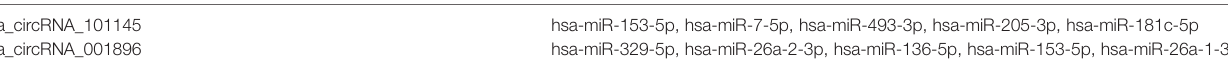
TABLE 3 | Validated differentially downregulated circRNAs in RRMS and the top 5 miRNA predicted to interact with them.